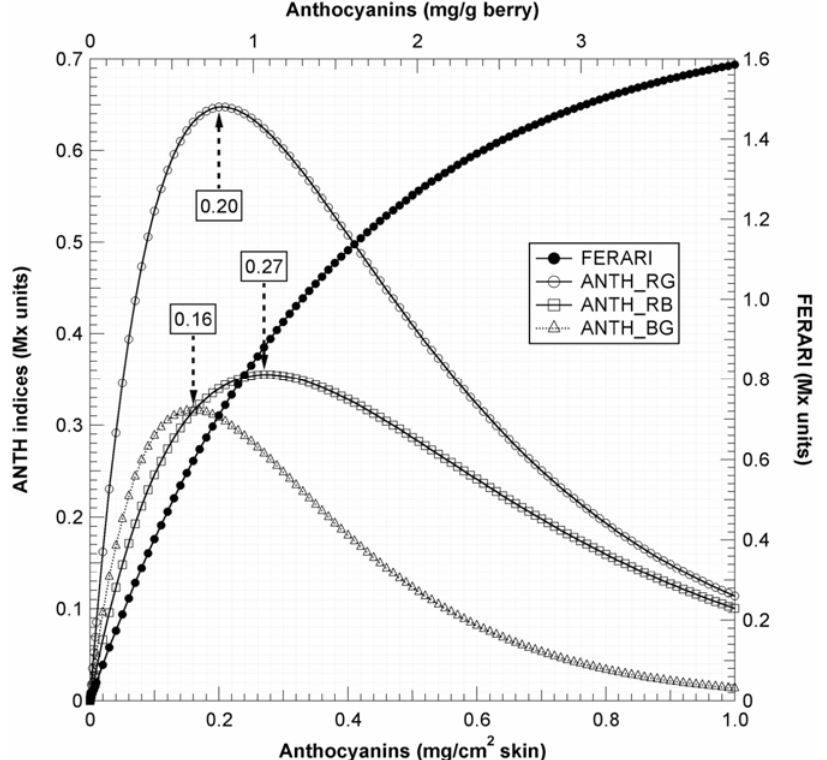
Figure 11. Simulated response curve for Multiplex ® indices covering the whole range of possible grape anthocyanin content. They were obtained using Equation (11) with red excitation for FERARI, and using Equation (13) for ANTH_RG, ANTH_RB and ANTH_BG with their respective excitations. The parameters of the equations were derived from the present calibration (data Figure 10). Maxima that can be attained by the three indices are indicated on the graph in mg anthocyanins per cm 2 of